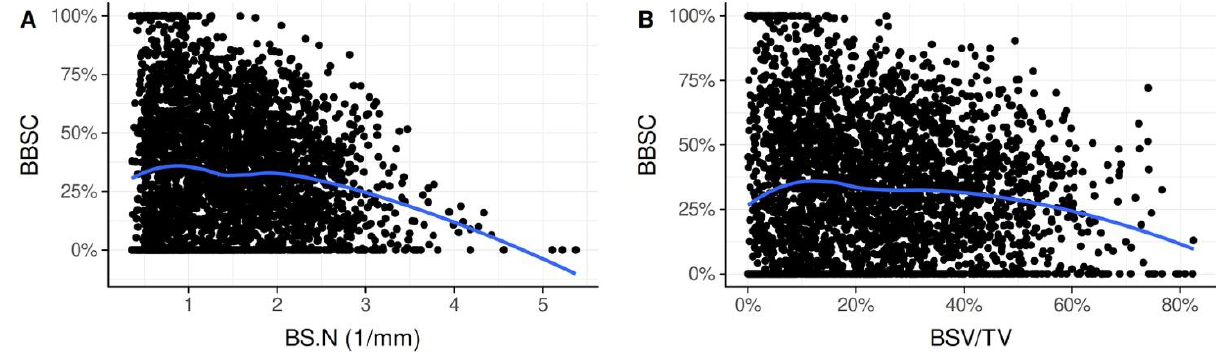
Figure 3. Scatter plots showing the association between BS.N and BBSC ( A ) and between BSV/TV and BBSC ( B ). Integration of BS is highest when 5–20% of the volume is occupied by BS particles. A high volume of BS per TV (>60%) and a high number of particles (>2.5 particles/zone) are associated with reduced osseointegration. BBSC: bone-to-bone substitute contact; BS.N: bone substitute number; BSV/TV: bone substitute volume per tissue volume.